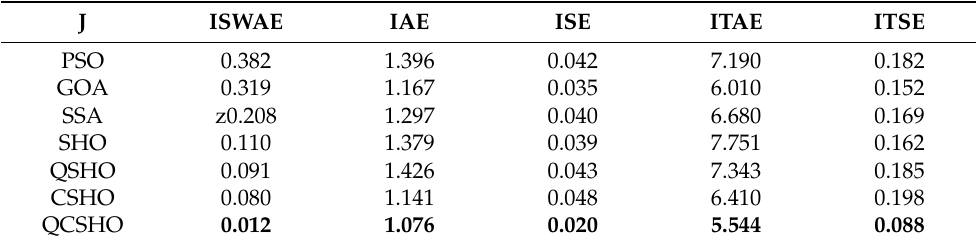
Table 3. Comparison of objective functions using PID